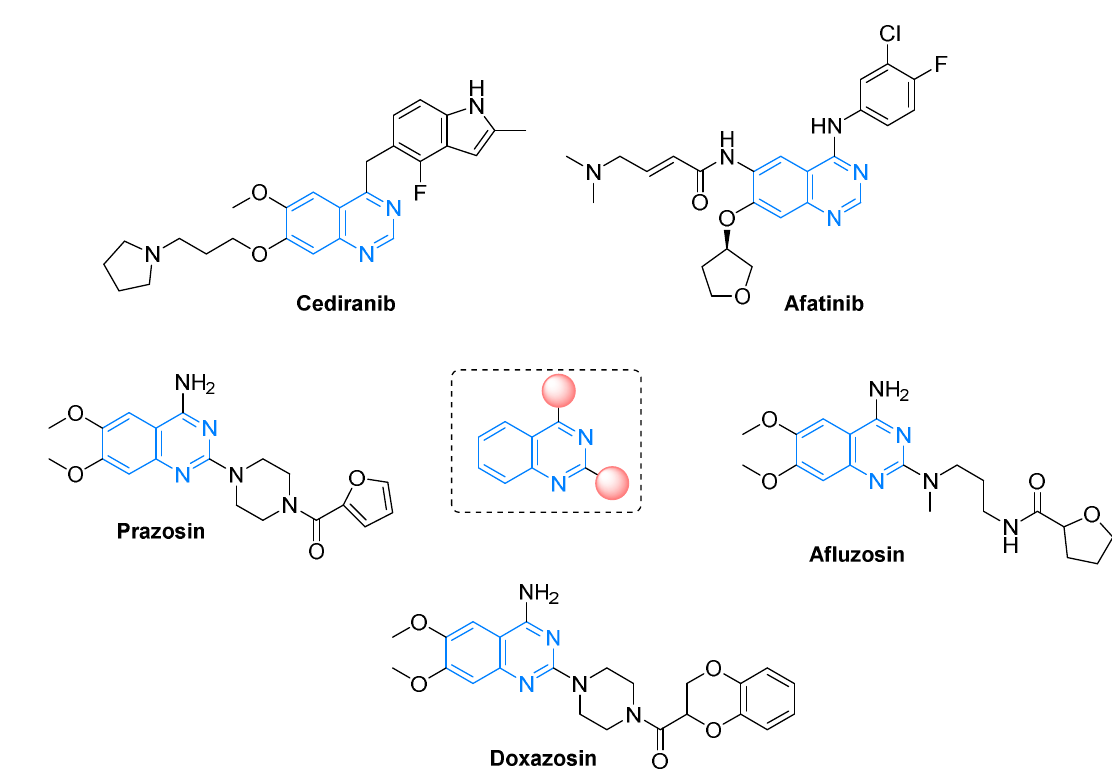
Figure 1. Structure of quinazoline-based drugs.